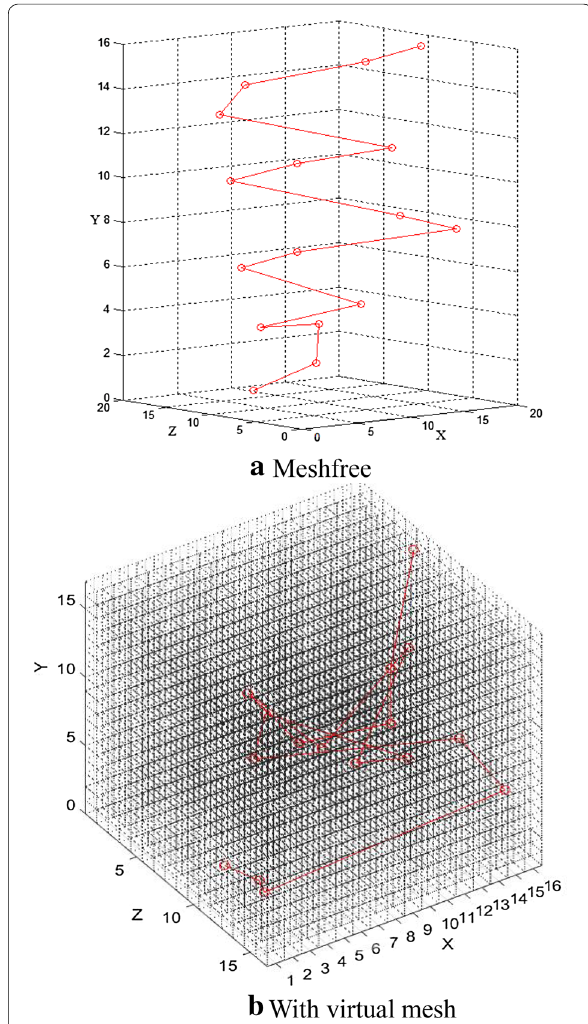
Figure 6 Optimized 3D path selected by information route nodes